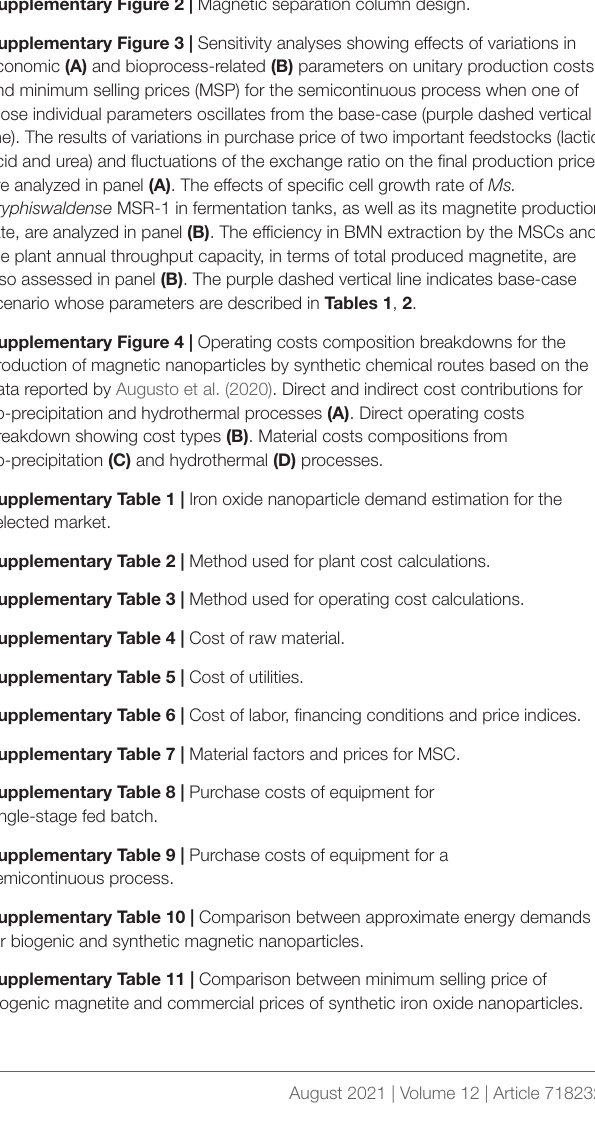
Supplementary Figure 2 | Magnetic separation column design.